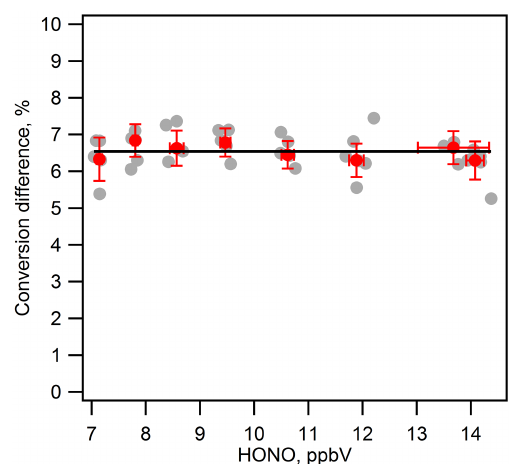
Figure 2. Difference in HONO conversion between 385 and 395nm UV-LEDs over a range of dilutions. Median values are in red, whilst all data are shown in grey. Linear fit is in black; error bars show standard deviation of the mean